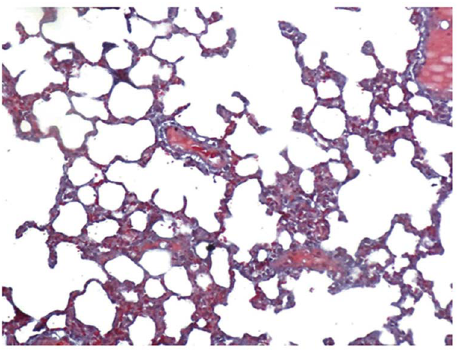
Figure 4. Masson stain of PQ group ( 6 200). The alveolar wall was significantly thickened, there was evidence of phoroblast hyperplasia and fibroglia fibrils, which were obviously hyperplastic.